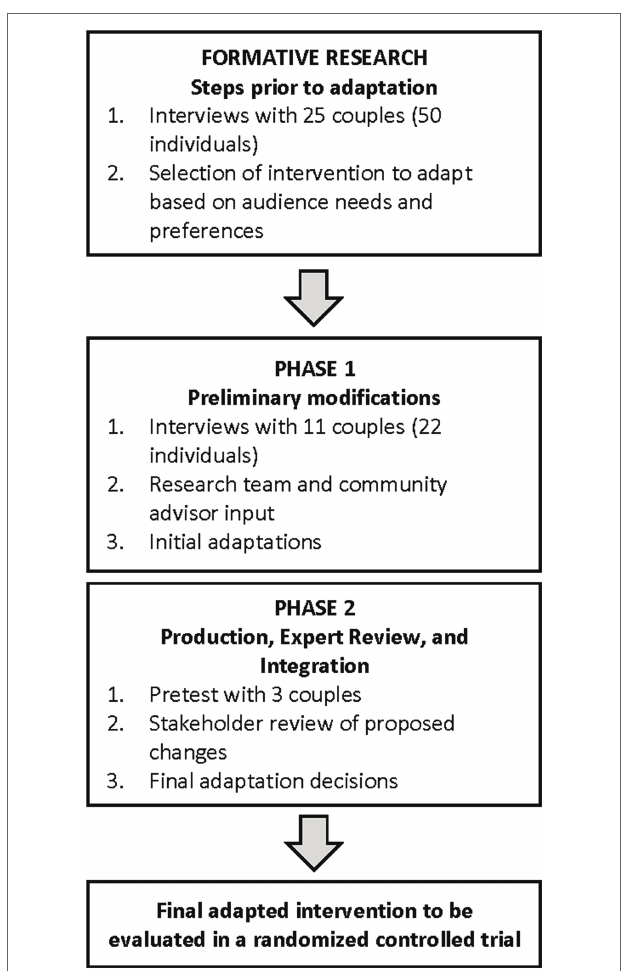
FIGURE 1 | Summary of intervention adaptation process. Formative research results are published